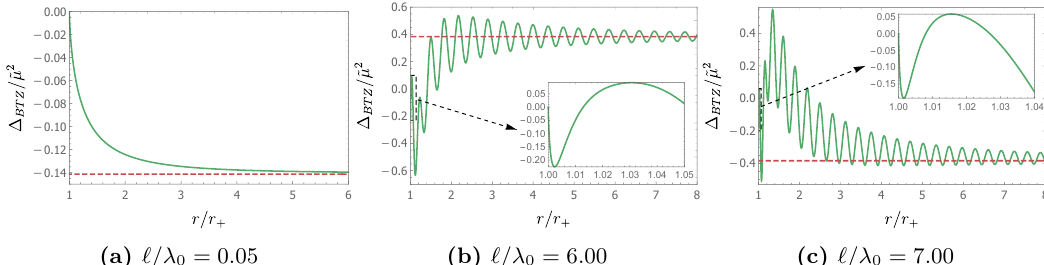
Figure 2 . The Lamb shift is plotted as a function of r/r + for (a) ‘/λ 0 = 0 . 05 , (b) ‘/λ 0 = 6 . 00 , (c) and ‘/λ 0 = 7 . 00 with the transition wavelength of the atom defined by λ 0 = 1 /ω 0 . Here, √ we have taken ˜ µ 2 = µ 2 / (8 2 π ) and M = 0 . 20 . The dashed red lines in all plots indicate the corresponding convergent values of ∆ BTZ / ˜ µ 2 (i.e., approximately equal to − 0 . 1413 in (a), 0 . 3833 in (b), and − 0 . 3831 in (c)) in the limit of r → ∞